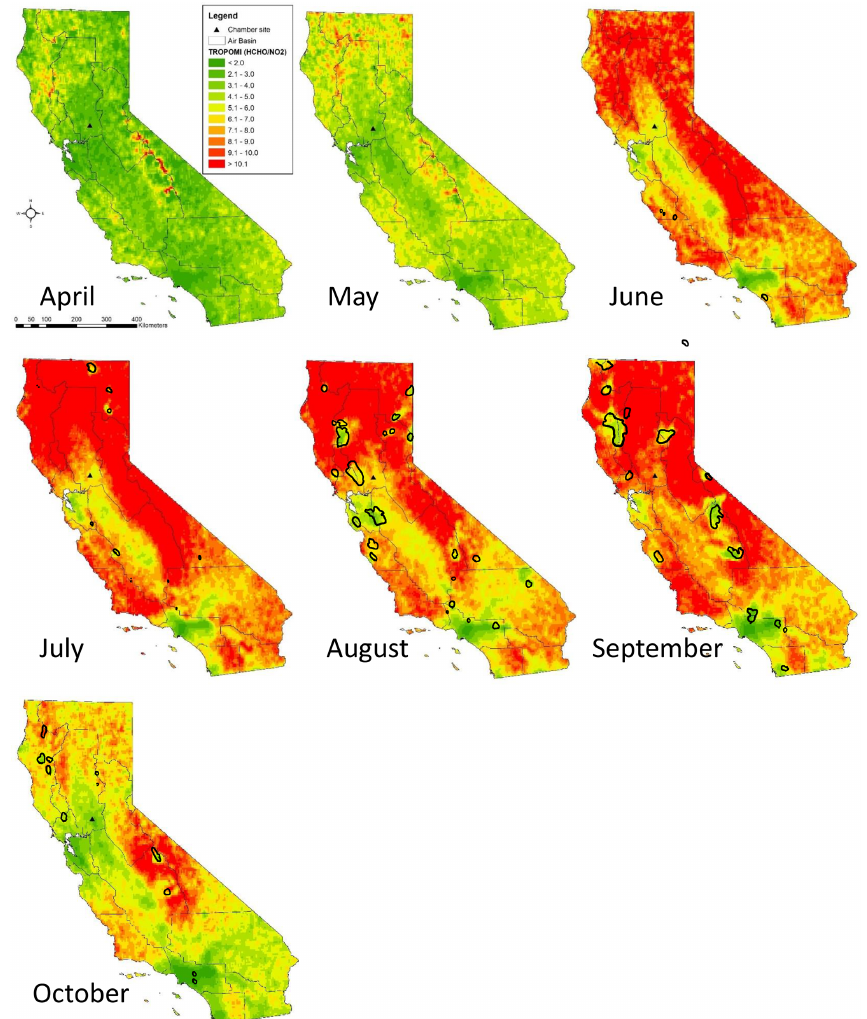
Figure 9. Spatial distribution of TROPOMI satellite (HCHO / NO 2 ) ratios in California for April–October 2020. TROPOMI NO 2 and HCHO data are re-gridded to 5km resolution when calculating monthly-average ratios. The black bold line circles the burned area in each month detected by MODIS from Fire Information for Resource Management System (FIRMS). The NO x -limited conditions correspond to HCHO / NO 2 ratios above